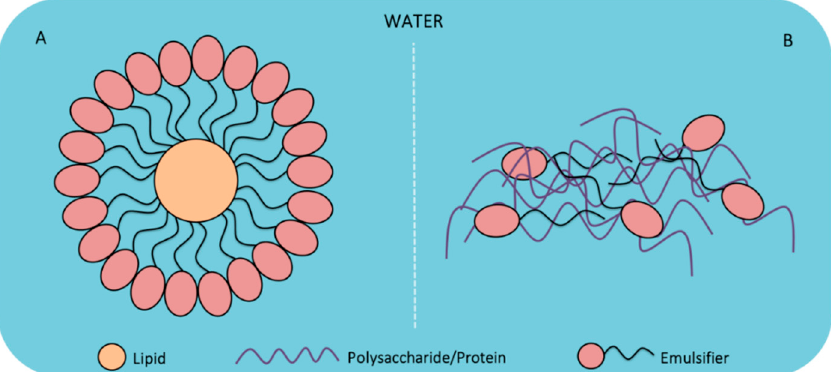
Figure 3. Main types of dispersed systems generated based on biopolymers, ( A ) emulsion oil/water (o/w) and ( B ) colloidal dispersions.